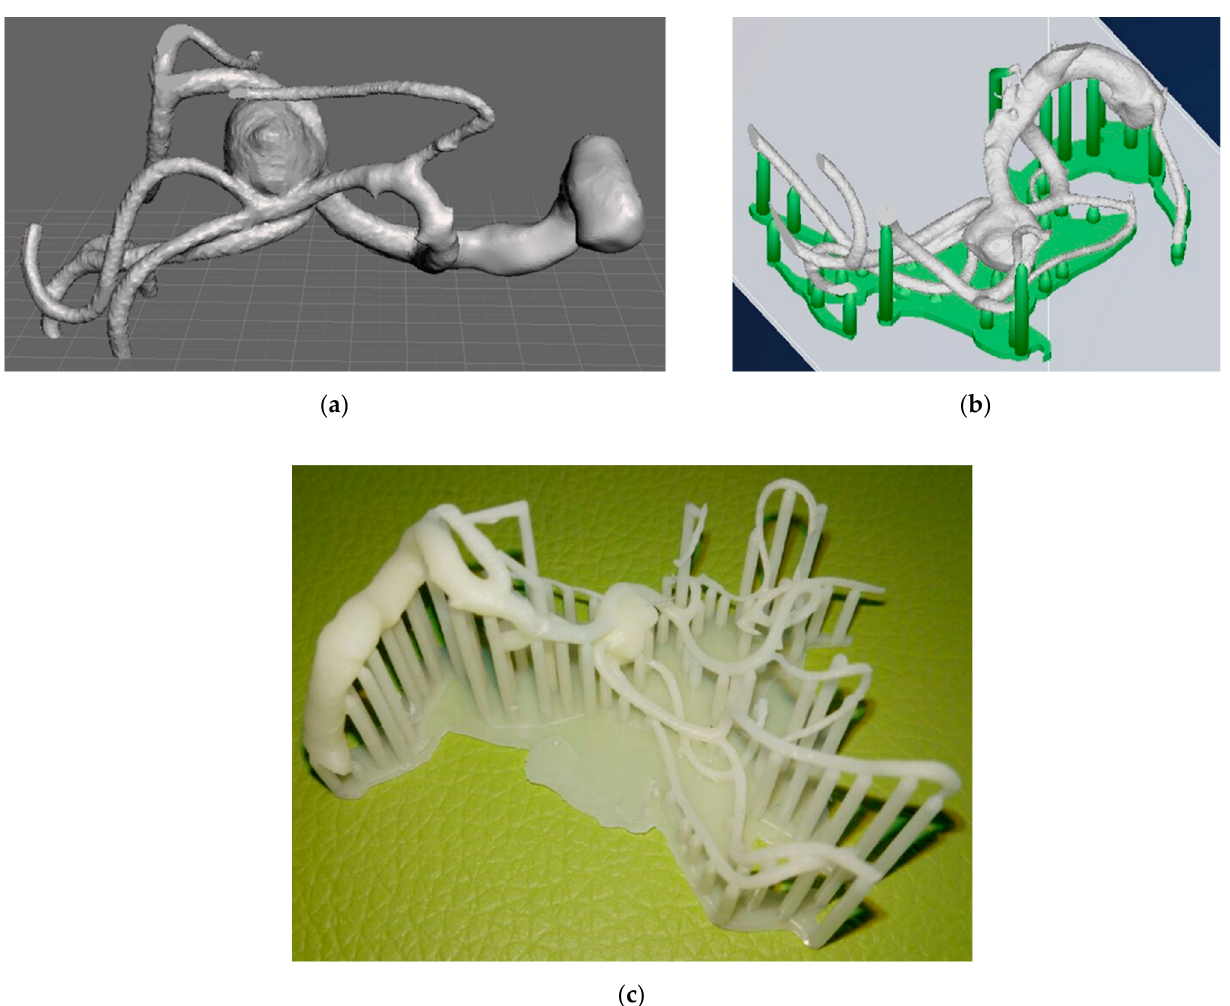
Figure 5. Patient #2 aneurysm reproduction and printing: ( a ) 3D model reconstruction of the aneurysm after simplification suggested by the neurosurgeons; ( b ) 3D model preparation for printing; ( c ) 3D printed model before the removal of the support structures.